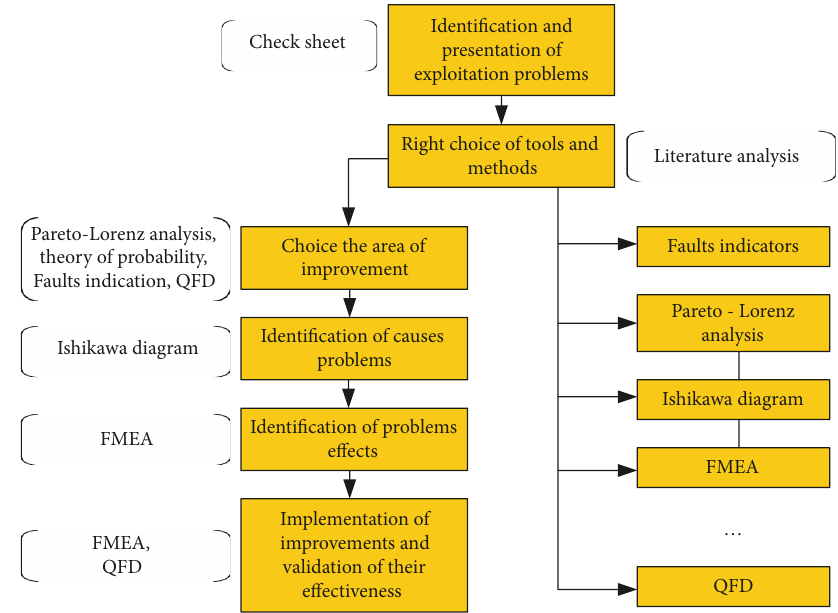
Figure 1: Improvement model of the exploitation process of means of passenger transport, on the example of urban buses.